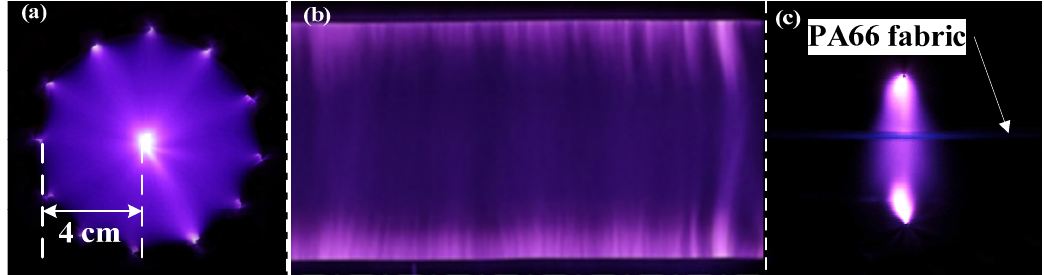
Figure 3. Images of the glow-like discharge: ( a ) The main view of the cylindrical electrode configuration in discharge; ( b ) The side view of the discharge with one pair of electrodes; ( c ) The PA66 fabric being treated.